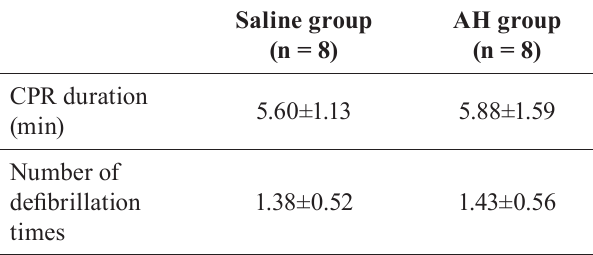
TABLE II - CPR parameters